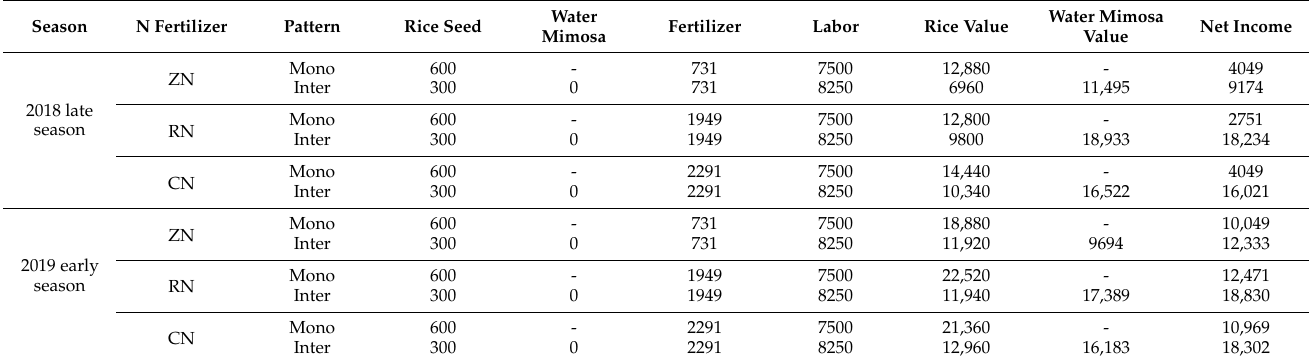
Table 3. Economic analysis (yuan ha − 1 ) of monocropping and intercropping treatments with the three different N fertilizer application